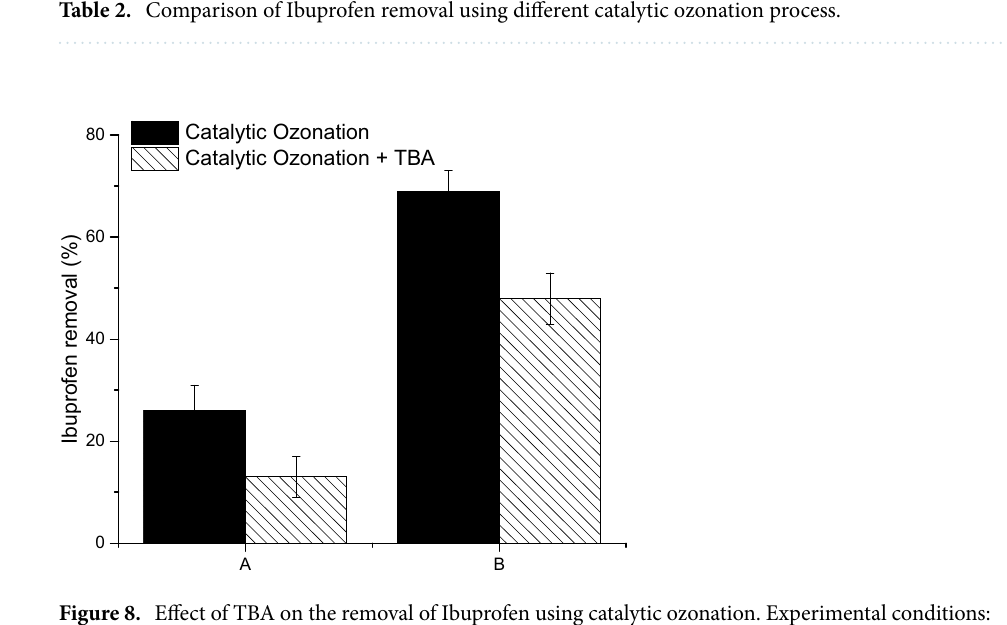
Figure 8. Effect of TBA on the removal of Ibuprofen using catalytic ozonation. Experimental conditions: pH—6.5, temperature 20 ± 1 °C, initial Ibuprofen concentration—5 mg/L, catalyst—1.00% (w/v), time—10